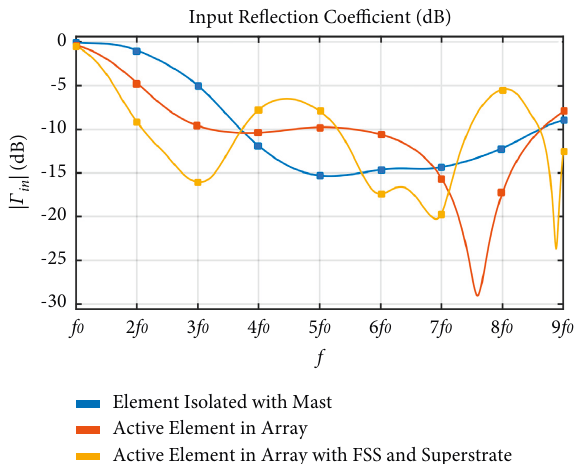
Figure 10: Frequency response of the average realized gain (in dBi) in the azimuthal plane for different TCA solutions. Only the horizontal (azimuth) polarization has been